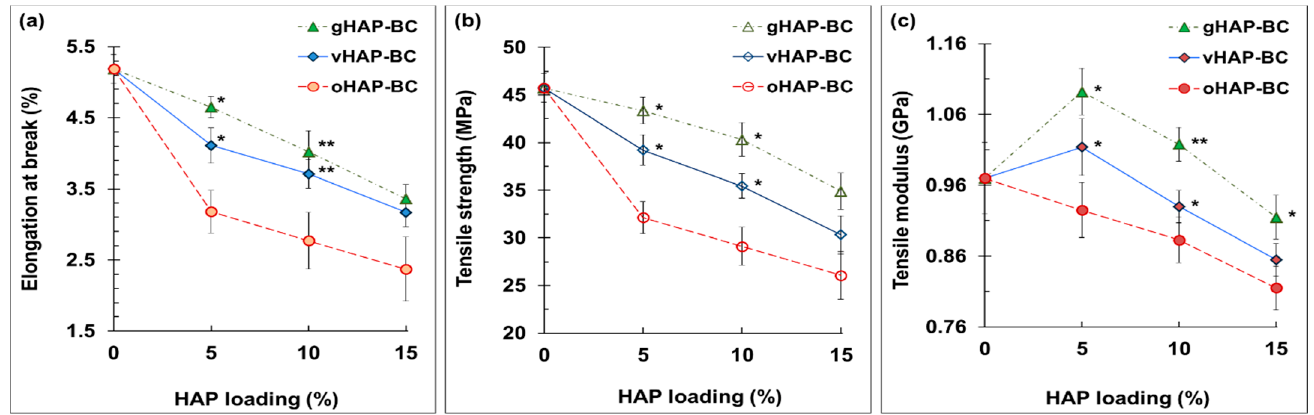
Figure 12. Tensile properties of HAP-BCs bone cements as function of HAP loadings. ( a ): elongation at break, ( b ): tensile modulus, ( c ): tensile strength. (Result = mean ± SD, n = 5; one-tail t -test, significant difference from the oHAP-BC group at the same HAP loading, * p < 0.05, ** p < 0.005).